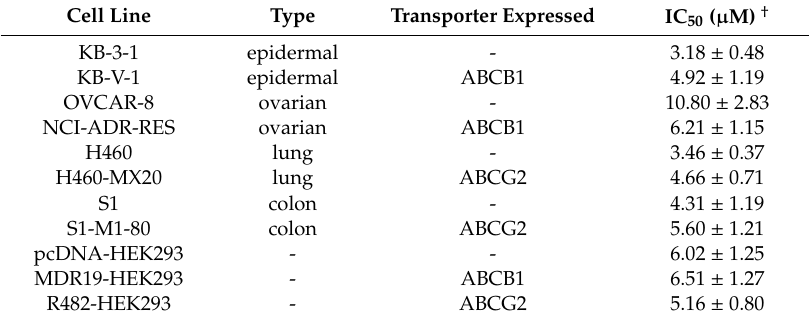
Table 1. Cytotoxicity of erdafitinib in human cell lines overexpressing ABCB1 or